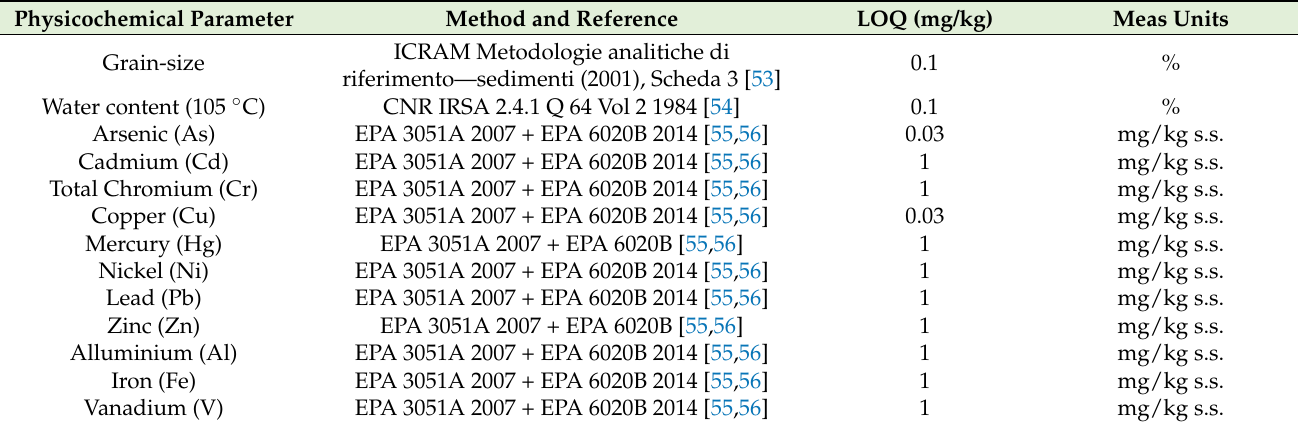
Table 1. Physicochemical analyses performed on powdered shells. In this table, methods, limit of quantification (LOQ) and measurement units are reported for each parameter.